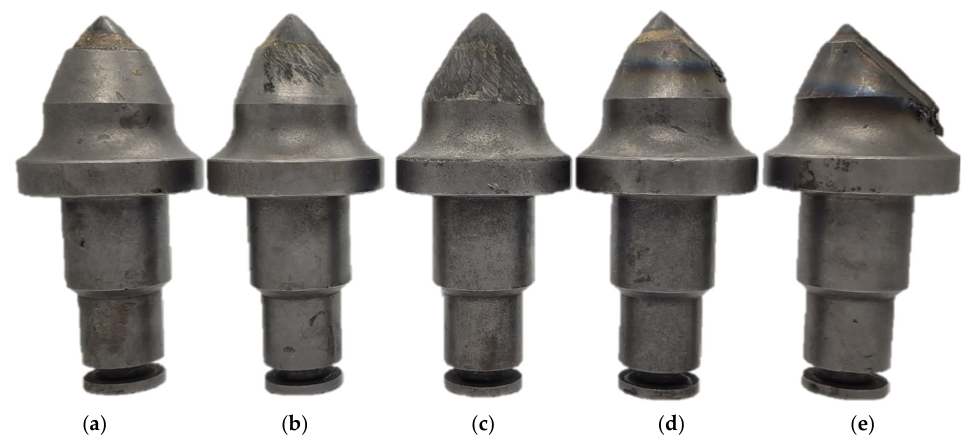
Figure 3. Image of all inspected conical pick specimens. The authors annotated them in the following manner: ( a )—CP0 (master model), ( b )—CP1, ( c )—CP2, ( d )—CP3, ( e )—CP4.